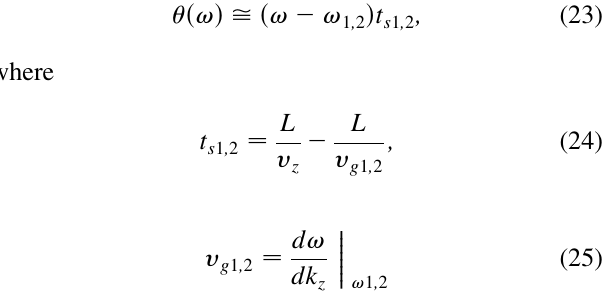
FIG. 3. The crossing of the waveguide mode and beam line dispersion curves in the cases of two frequencies and zero- slippage solutions.